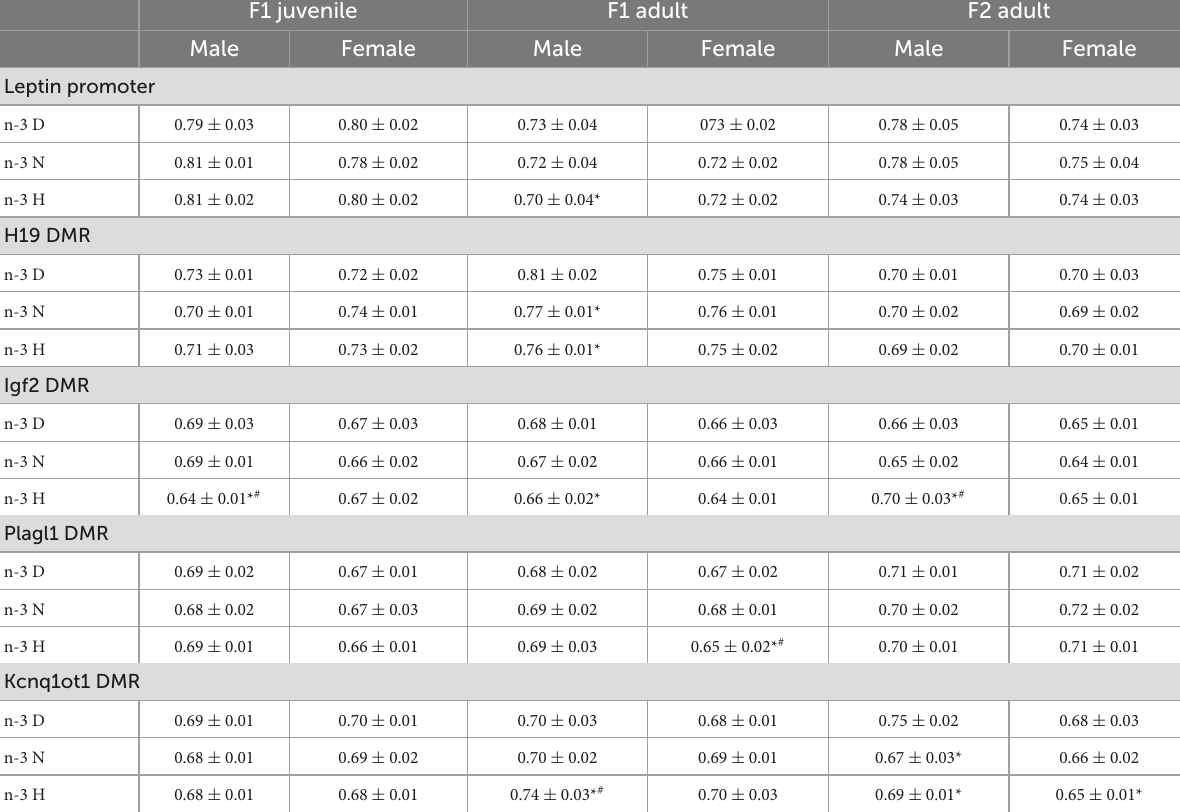
TABLE 6 Effects of paternal n-6: n-3 PUFAs on DNA methylation of the leptin promoter and DMRs of imprinted genes in the adipose